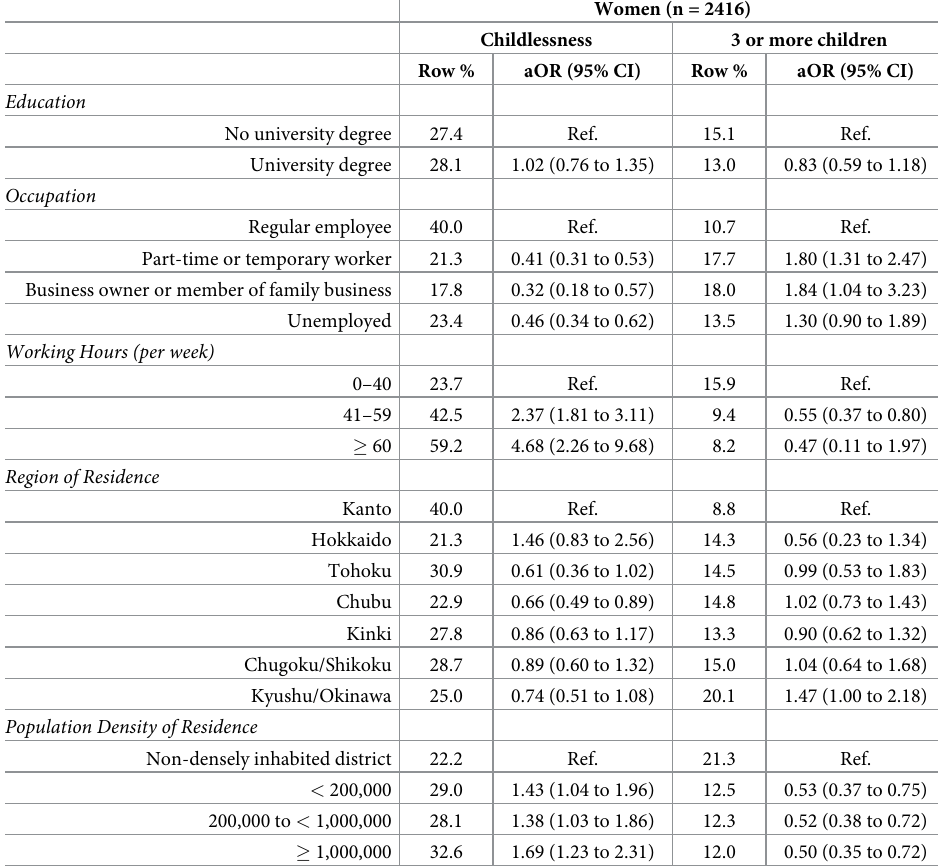
Table 2. Association of sociodemographic factors with childlessness (having no children) and having 3 or more children among women born